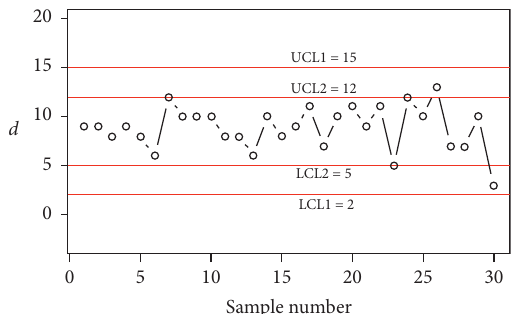
Figure 5: The Birnbaum–Saunders chart based on the RS method for the coupon data.